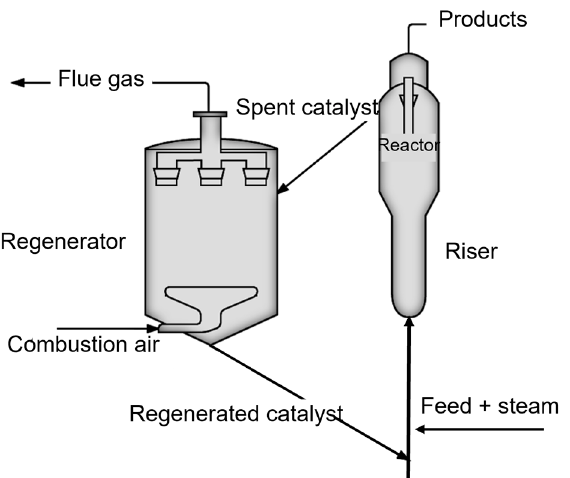
Figure 1. Schematic depiction of a Fluid Catalytic Cracking Unit (FCCU).